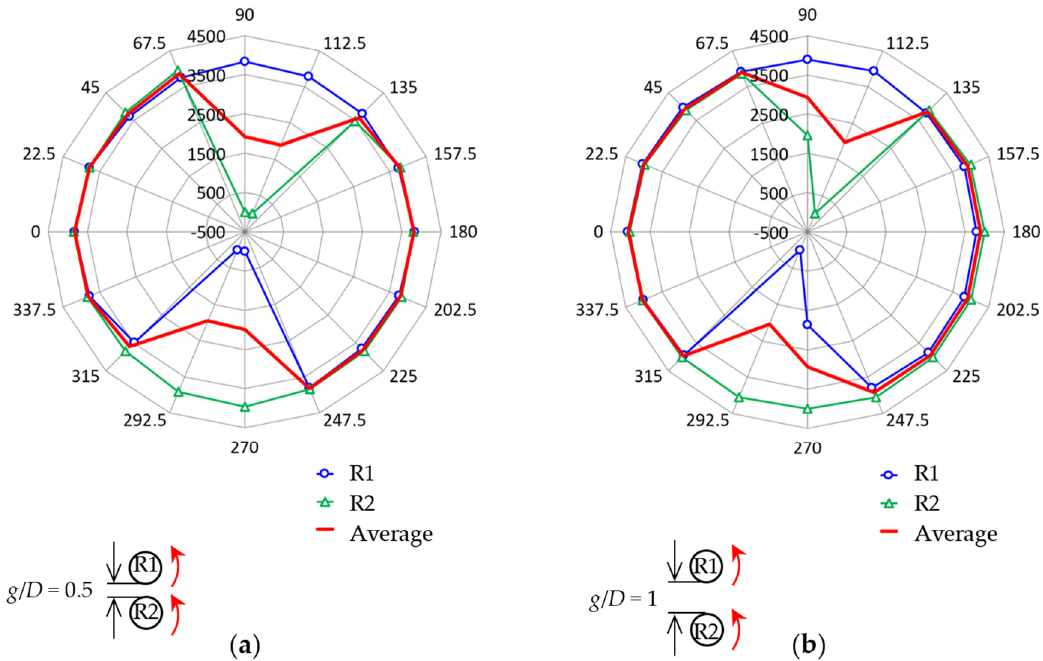
Figure 13. CO configuration of 16-wind-direction dependence on two VAWTs at V = 14 m/s: ( a ) g / D = 0.5; ( b ) g / D = 1.